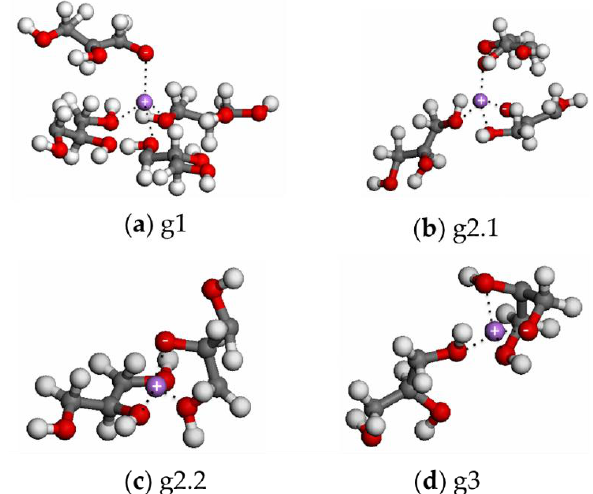
Figure 2. Coordination geometries assumed by glycerol molecules upon coordination of Li + cations. Color legend: C (grey), O (red), H (white), Li (violet). Li–O interactions are highlighted with a dotted line. ( a ) g1 coordination geometry, with four monodentate glycerol ligands; ( b ) g2.1 coordination geometry,